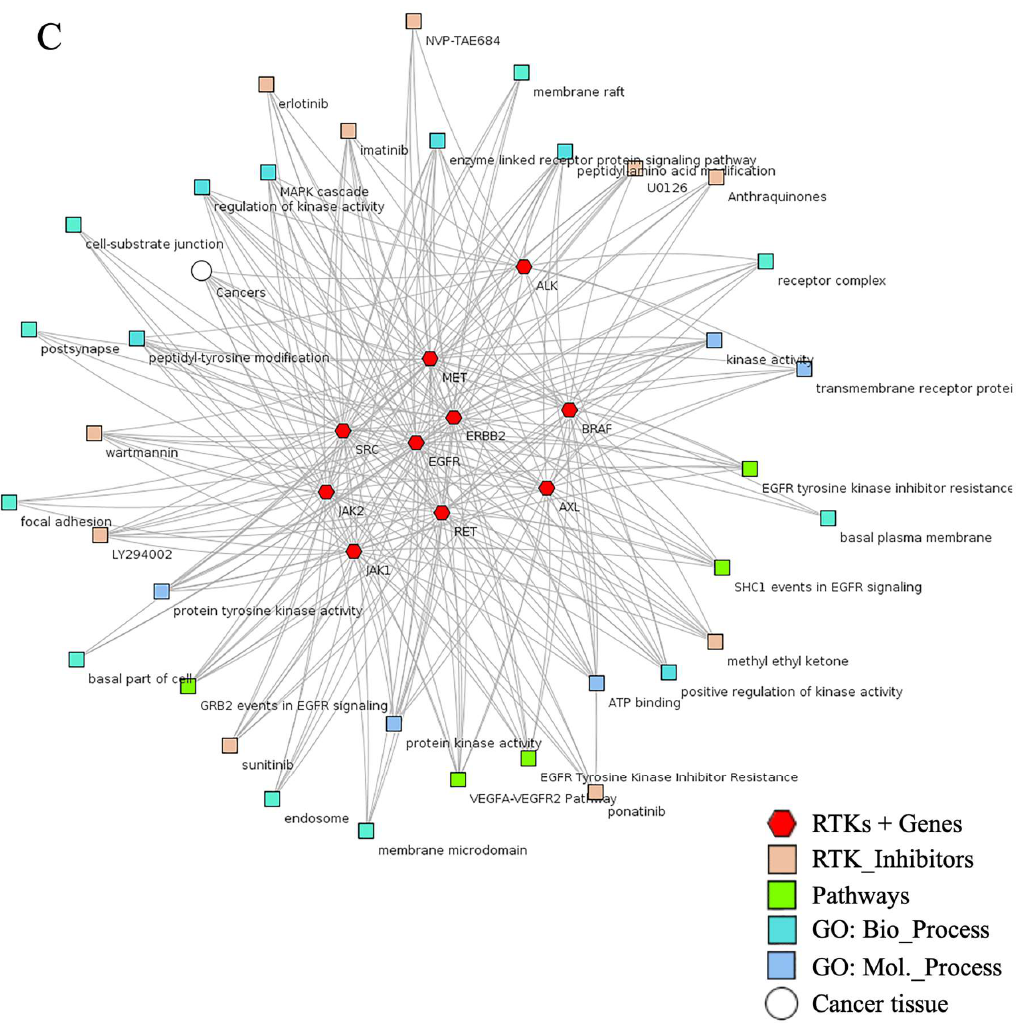
Figure 5. Mutation of RTKs caused mutation in KRAS, PIK3CA, BRAF, PTEN, and mTOR ablation that induced tumori- genesis. ( A , B ) Mutational changes occurred in most RTKs, including EGFR, ERBB3, MET, ALK, RET, and FGFRs, which involved diverse mediators that induced cell proliferation. Pathways retrieved from cBioPortal patient cancer databank. ( C ) Association of RTKs with their inhibitor and major GO were visualized by an abstracted network